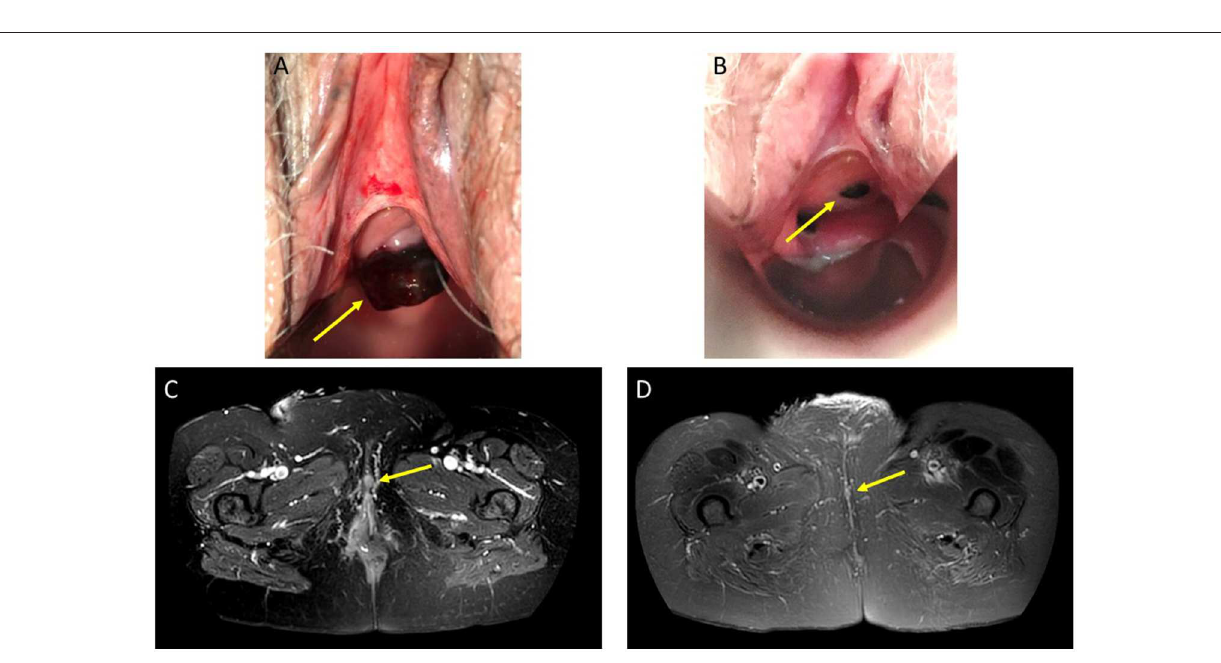
FIGURE 2 | Clinical and MR image of intravaginal mucosal metastasis of a malignant melanoma of the urethra. A/B: Visual appraisal with speculum. (A) Target lesion before injection of T-VEC. Baseline image shows a pigmented ulcerated mucosal tumor (arrow). (B) Target lesion after seven injections of T-VEC: partial response with substantial regression of the injected mucosal metastasis (arrow) and cessation of intravaginal bleeding. C/D MR image. (C) Transverse T2-weighted fat suppressed MR image shows labial metastasis (arrow) before injection of T-VEC. (D) Transverse T2-weighted fat suppressed MR image 2 months upon T-VEC therapy shows complete disappearance of labial metastasis (arrow indicating the original